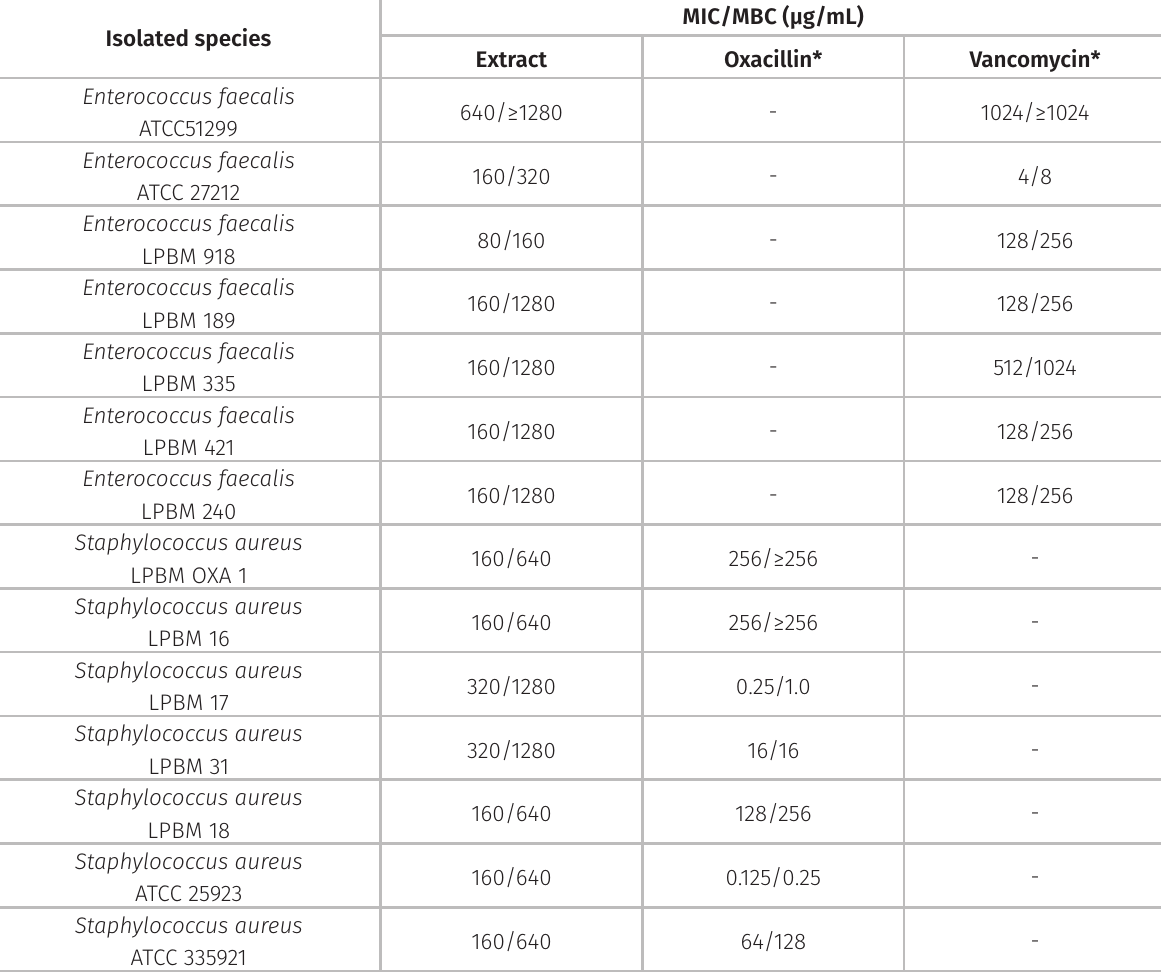
Table VI. Antibacterial activity of the dried extract of S. cumini measured by the minimal inhibitory concentration (MIC) and minimum bactericidal concentration (MBC)